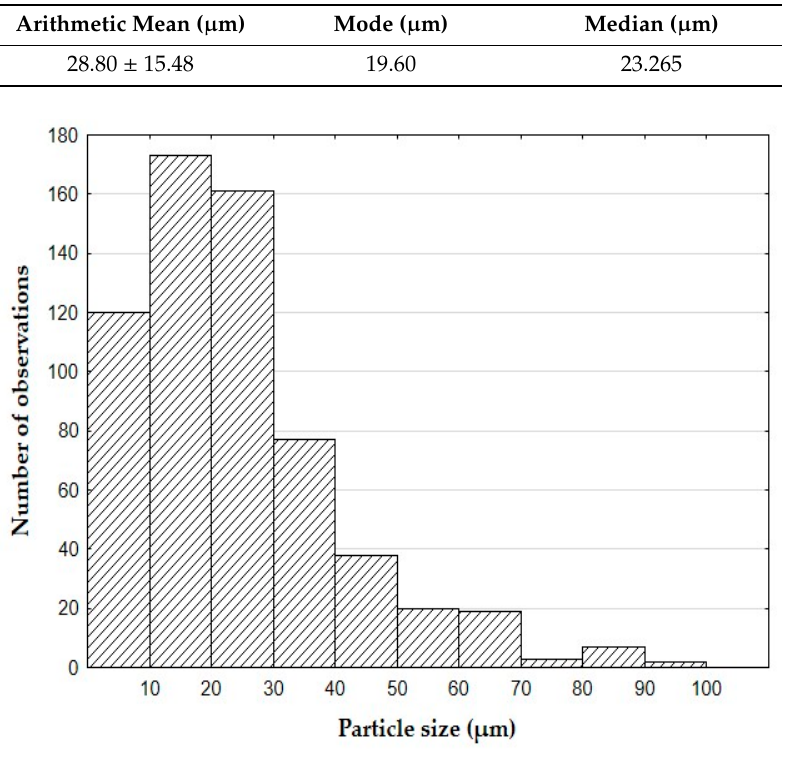
Table 1. Fraction size of the filler particles.